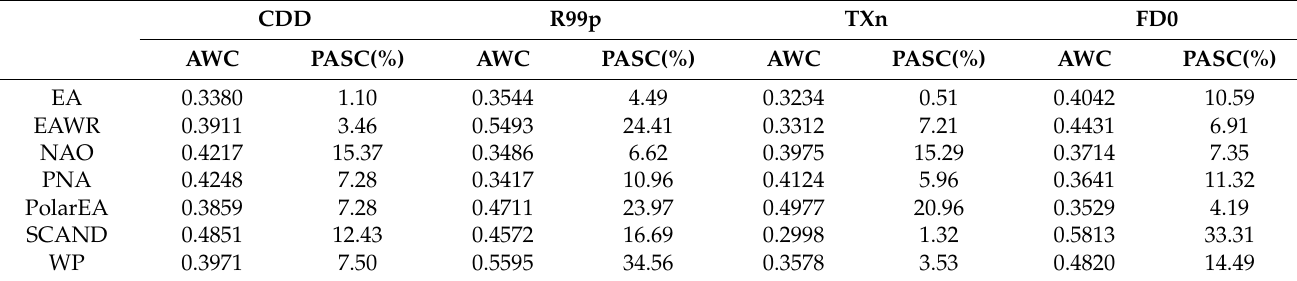
Table 5. The average wavelet coherence (AWC) and the numbers of power (PNPS) of the wavelet transform coherence (WTC) between extreme climate indices and teleconnection patterns in the Bei- jing – Tianjin – Hebei region.